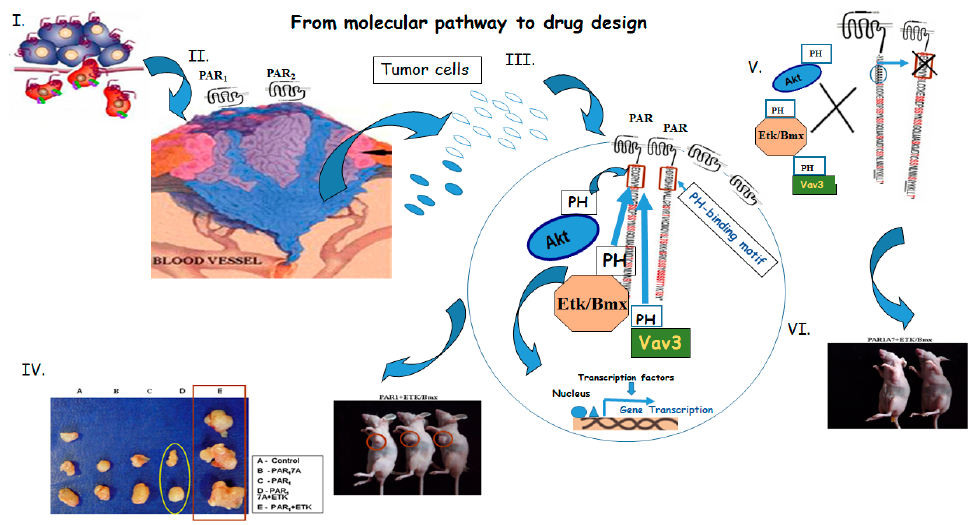
Figure 1. From molecular pathway to drug design. I . Scheme of epithelial cells invading basement membrane. II . Scheme of tumor cells that invaded the basement membrane and are spreading via the vascular system. III . The subfamily of GPCRs; PAR oncogenes display a PH-binding domain within their cytoplasmic C-tails. Signal proteins that possess PH-domain such as; Akt, Etk/Bmx and Vav3 can associate with PAR C-tails initiating thereby a tumor signaling cascade. IV . PAR-derived tumors are generated upon the inoculation of cells overexpressing PAR 1 (or PAR 2 ) in the mouse fourth mammary gland. V . Application of an inhibitor of the PAR PH-binding domain, effectively abrogates PH-signal protein association with PARs. VI . In the presence of the PH-binding site inhibitor, no to nearly very small tumors are developed.